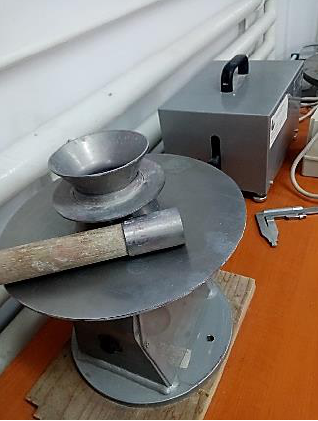
Figure 7. Flow table apparatus.